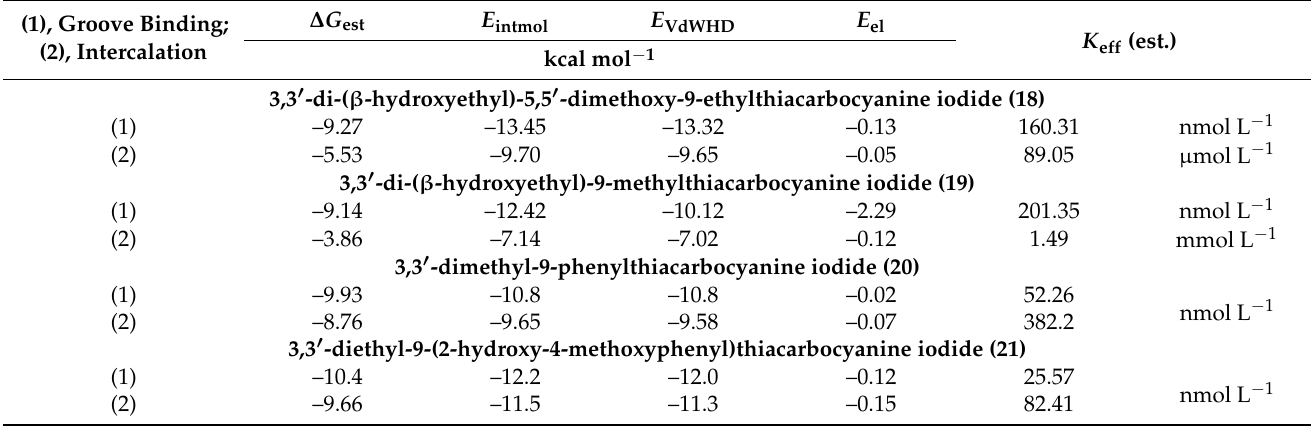
Table 1. Values of free energy of binding ( Δ G est , kcal mol − 1 , at 25°C), intermolecular energy ( E intmol ,